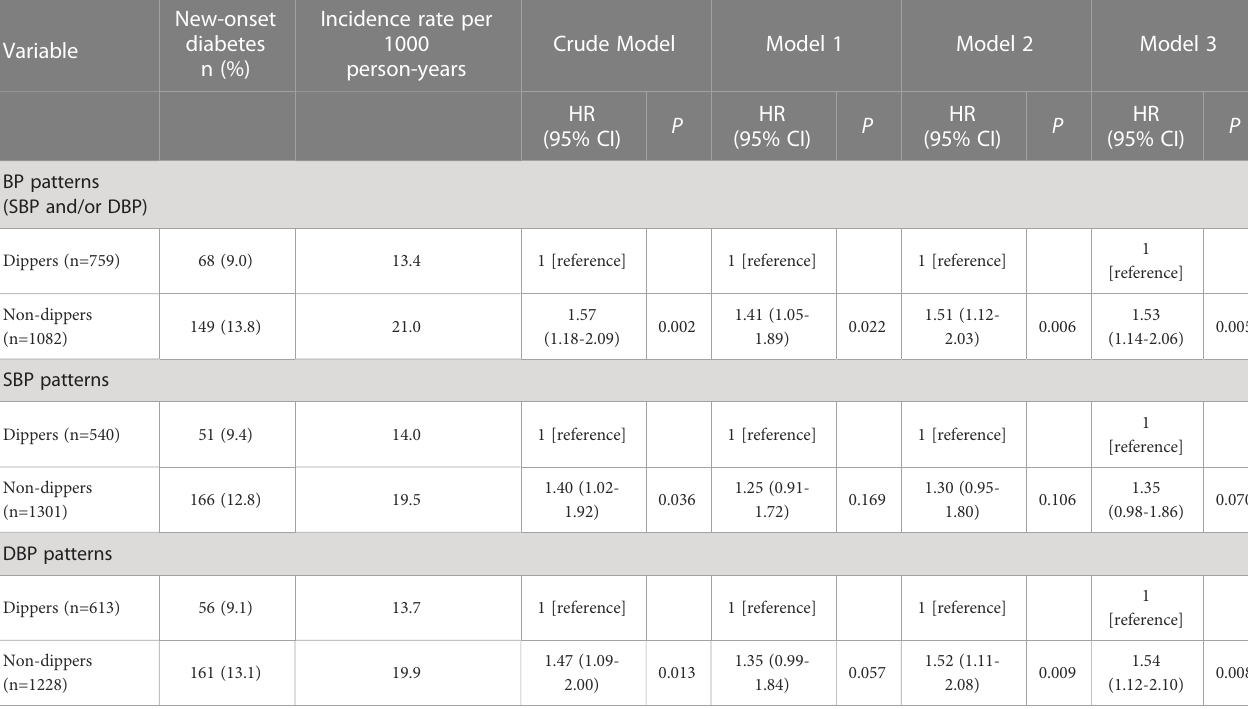
TABLE 2 Multivariate Cox regression analysis of association between circadian BP patterns and new-onset diabetes.